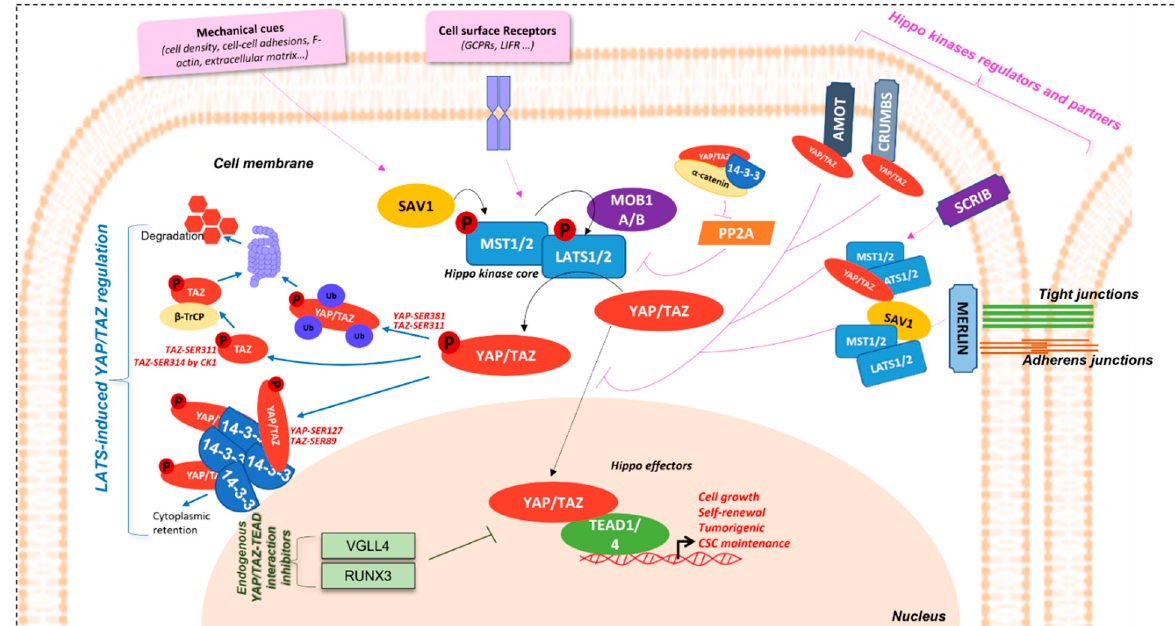
Figure 1. Hippo/YAP/TAZ-TEAD signalling pathway. Schematical representation of Hippo sig- nalisation network. Regulation of YAP/TAZ effectors by LATS are represented by the blue arrows, endogenous YAP/TAZ-TEAD inhibitors in green, and Hippo kinases regulators and partners in pink.